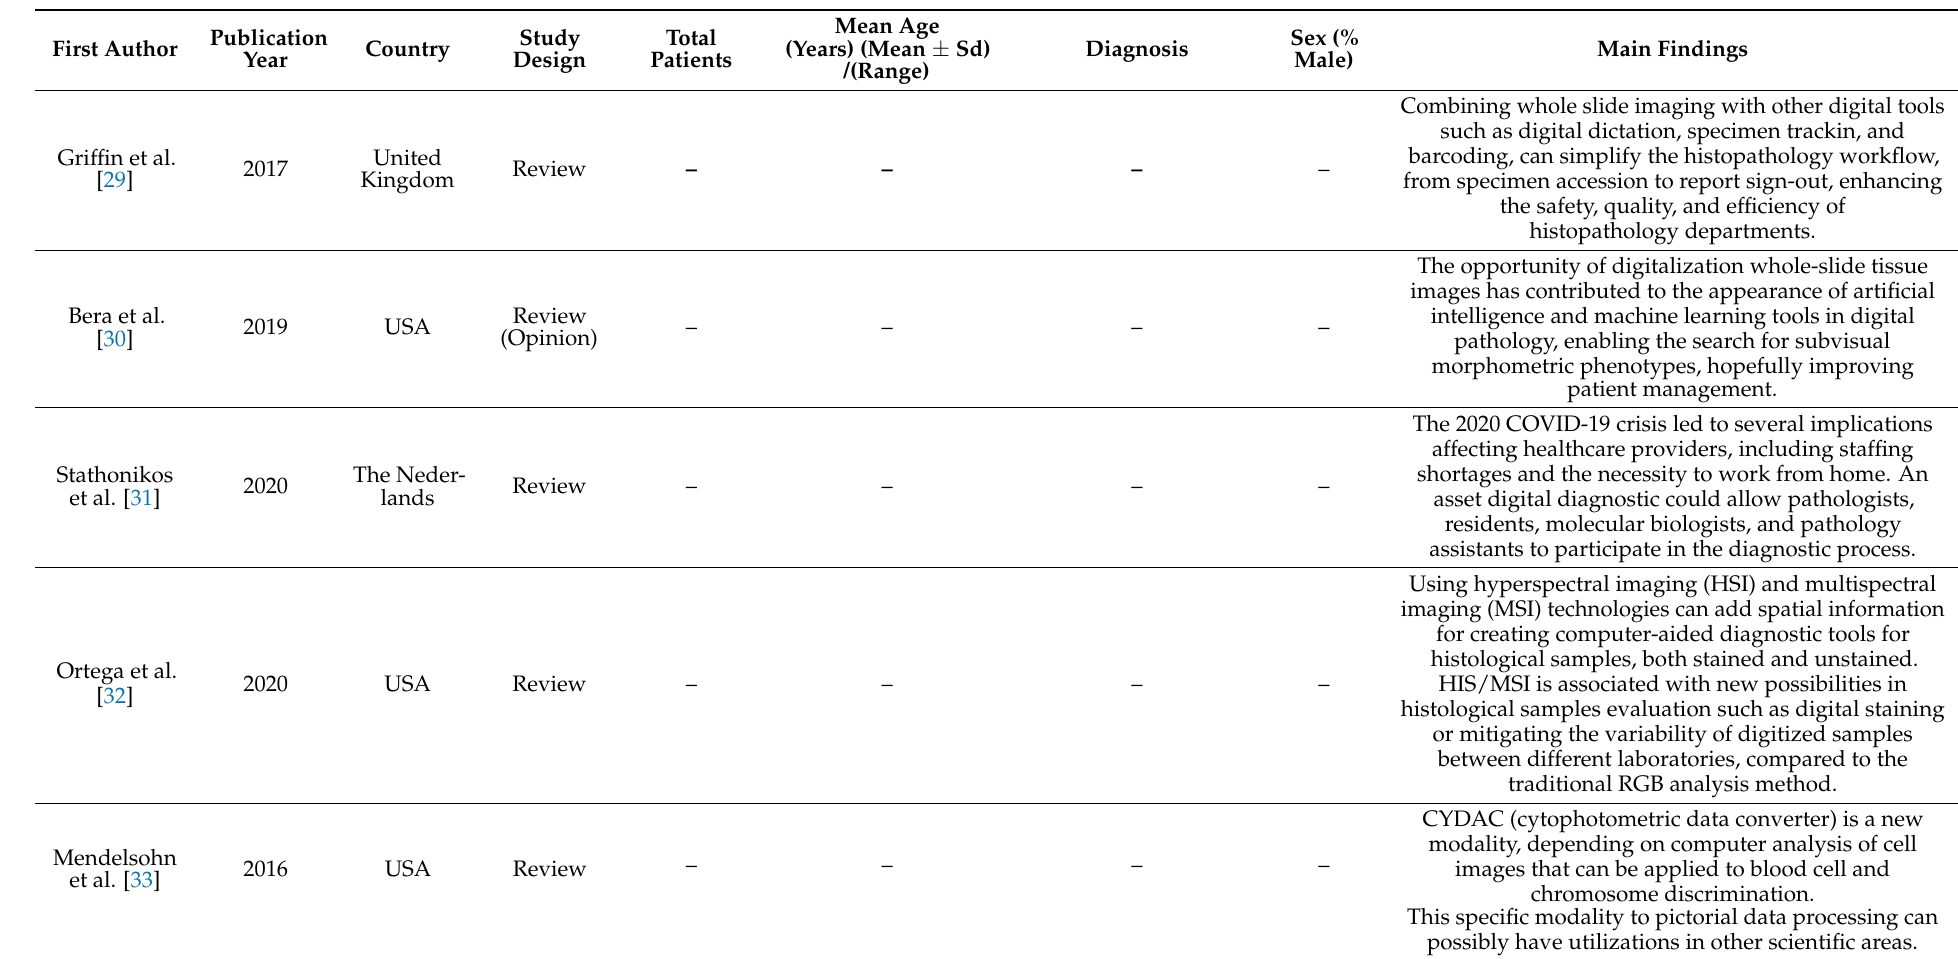
Table 3. Studies assessing automated digital